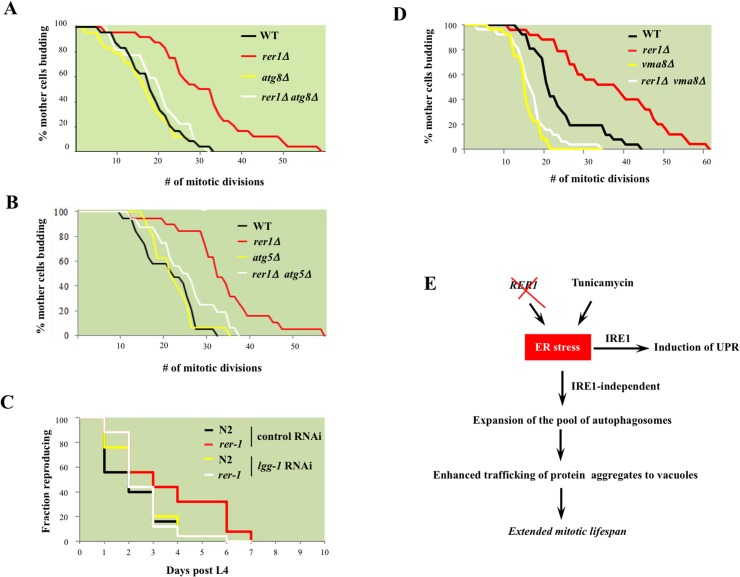
The requirement for intact cellular catabolism in extension of lifespan in yeast and worm rer1 mutants.Mitotic lifespan in wild type or rer1Δ mutants harboring a deletion of the autophagosome components ATG8
(A) or ATG5
(B). The mean mitotic lifespans for the samples in (A) were WT (16.5 days), rer1∆ (27.5), atg8∆ (15.5) and rer1∆ atg8∆ (18.5). The rer1∆ mean mitotic lifespan was significantly different from the WT (p-value<0.01), whereas the differences between WT, atg8∆ and rer1∆ atg8∆ were not. Similarly, in (B) the mean mitotic lifespan difference between WT (17.5 days) and rer1∆ (38.5) was statistically significant (p-value<0.01), whereas the differences between WT, atg5∆ (17.5), and rer1∆ atg5∆ (18.5) were not. C. Reproductive lifespan in N2 (n = 25) and rer-1(tm5219) (n = 25) worms treated with control or lgg-1 RNAi. D. Deletion of VMA8, encoding a vacuolar proton pump subunit, abolishes the extended lifespan in yeast rer1Δ mutants. The differences between WT (21.5 days), vma8∆ (15.5; p-value < 0.01) and rer1∆ vma8∆ (17.5; p-value < 0.05) were statistically significant. E. Autophagy, induced in response to elevated ER stress in rer1Δ or following exposure to the ER stressor (TM), traffics cytoplasmic aggregates to the vacuoles and in doing so delays mitotic senescence (details in text).